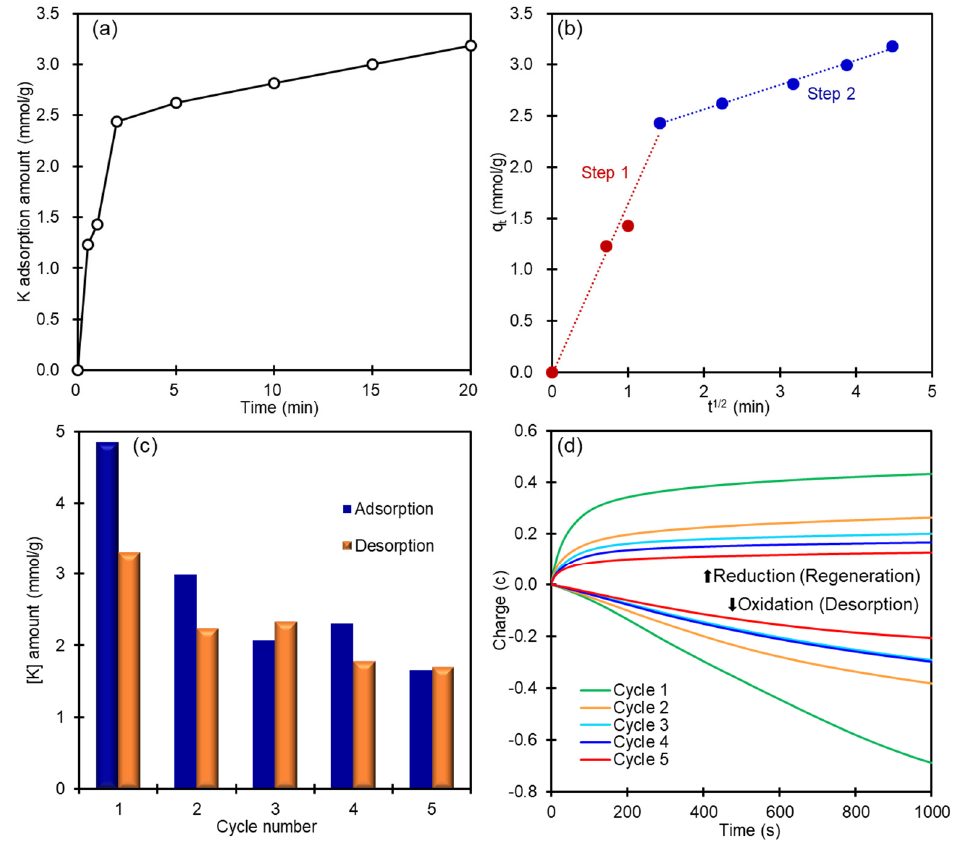
Figure 3. Potassium adsorption from artificial seawater using CoHCF modified electrode. ( a , b ) adsorption kinetic curve and intraparticle diffusion model, ( c ) Change of K + amount in 5 adsorption-desorption-regeneration cycles, and ( d ) charge generated in each cycle of K + adsorption and desorption in an electrochemical system.